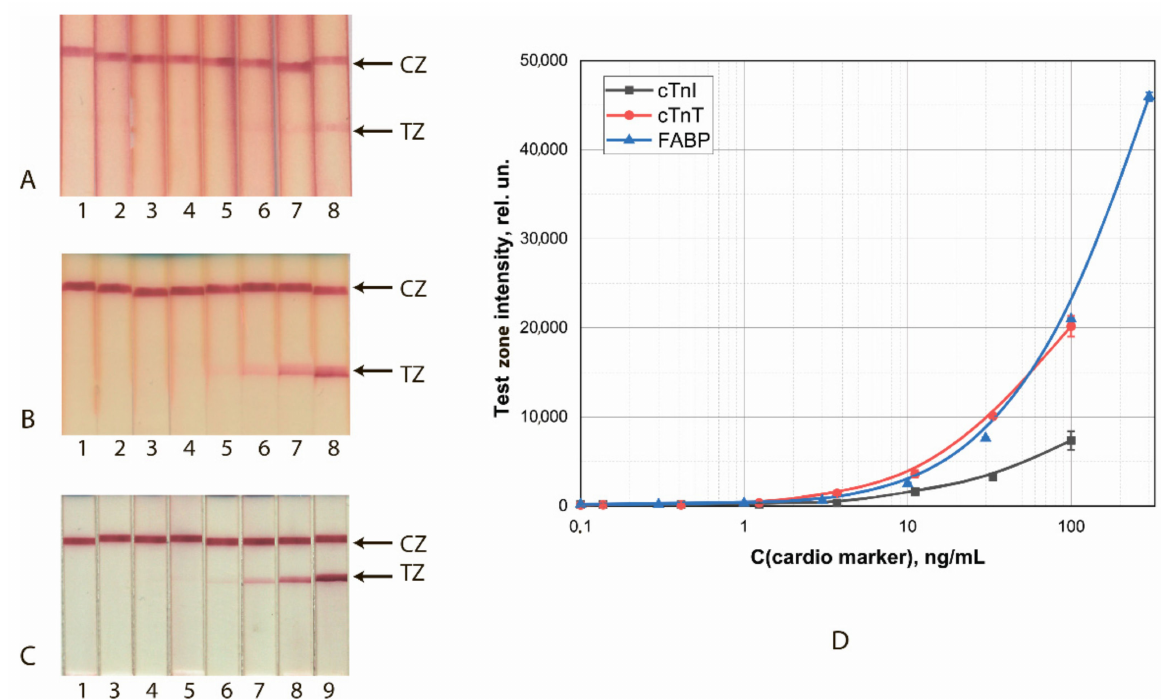
Figure 1. LFIA of cardio markers by test systems using the conjugates GNSs (30 nm)—Ab2/cTnI ( A ), GNSs (30 nm)— Ab4/cTnT ( B ), and GNSs (20 nm)—Ab6/FABP ( C ). ( A – C ) appearance of test strips after analysis of samples containing 0 (1), 0.1 (2), 0.4 (3), 1.2 (4), 3.4 (5), 11 (6), 33 (7), 100 (8), and 300 (9) ng/mL of the analytes. ( D ) Dependence of the intensity of coloration of the TZs on the concentration of